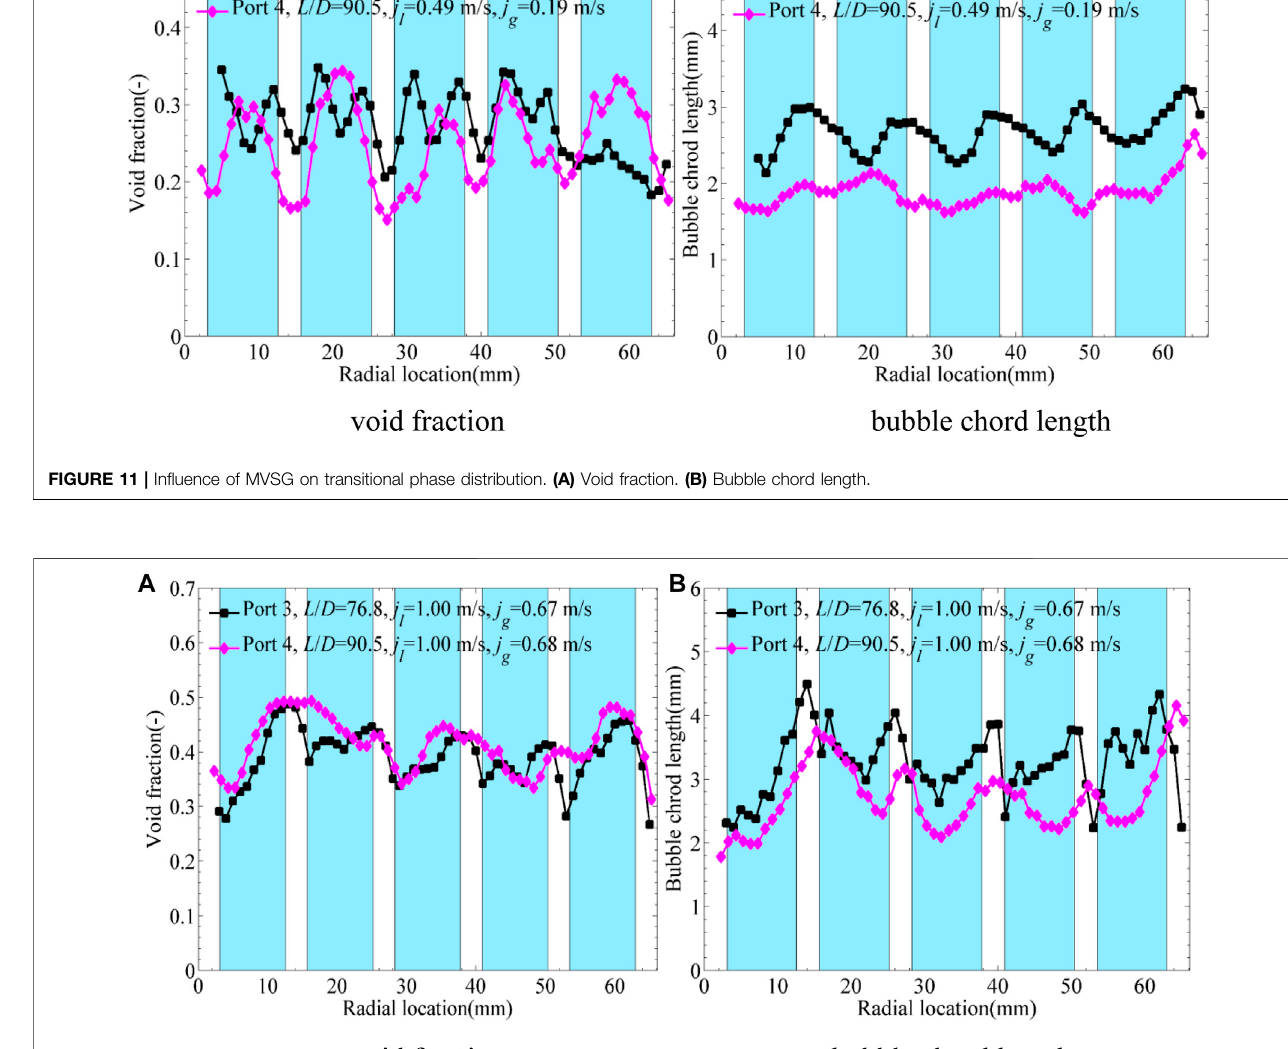
Frontiers in Energy Research |